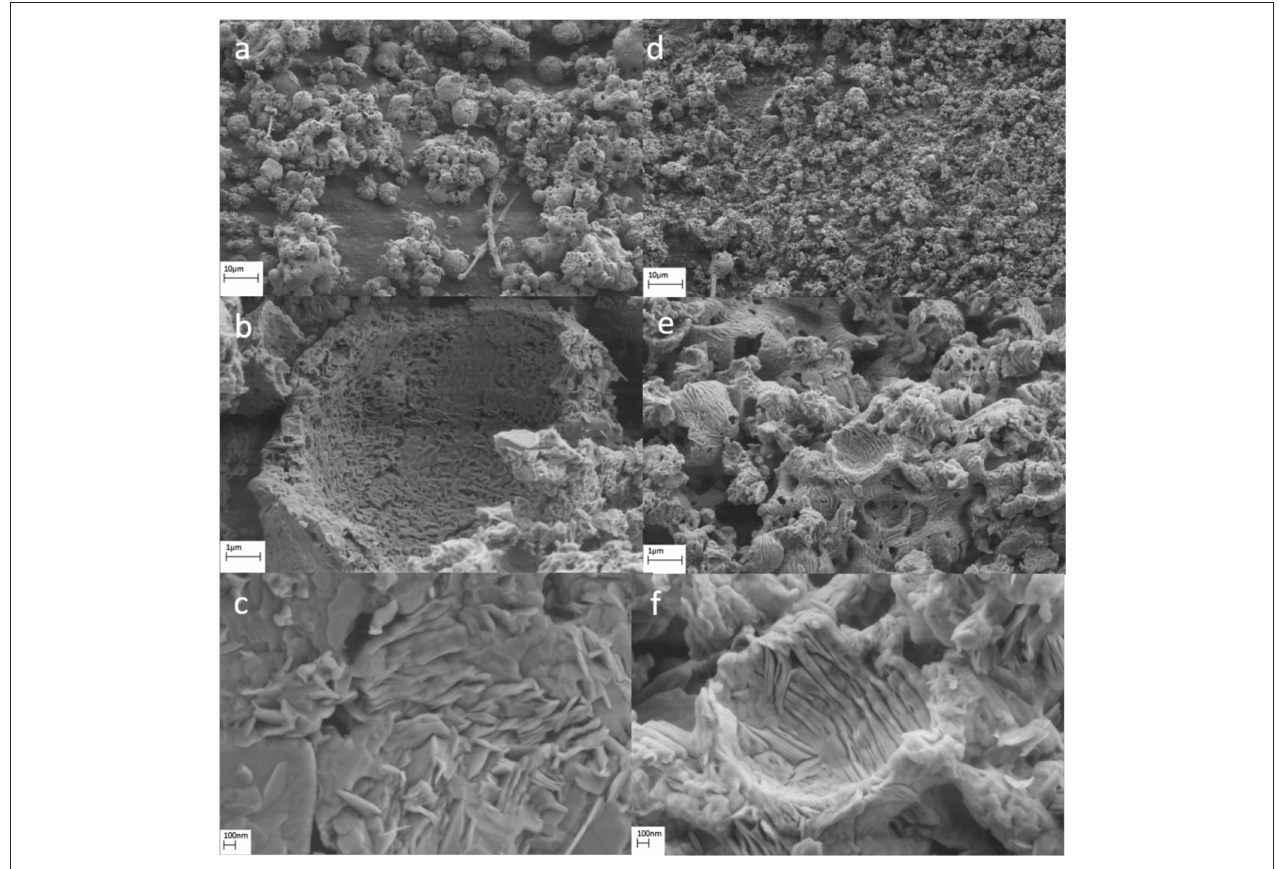
FIGURE 5 | Scanning electron microscopy images for calcined particles from (a–c) sucrose based solutions (d–f) DMF based